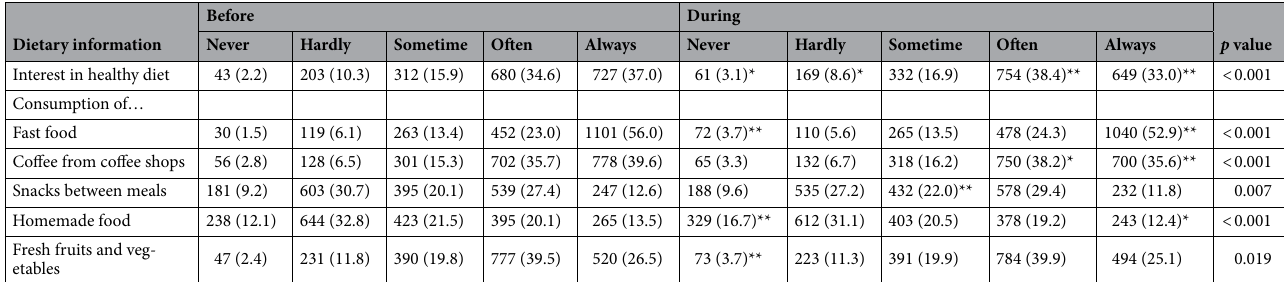
Table 5. Dietary information in all subjects. Data presented n (%). * and ** represented p value significant at < 0.05 and 0.01 level using Cochran’s Q test and McNemar’s